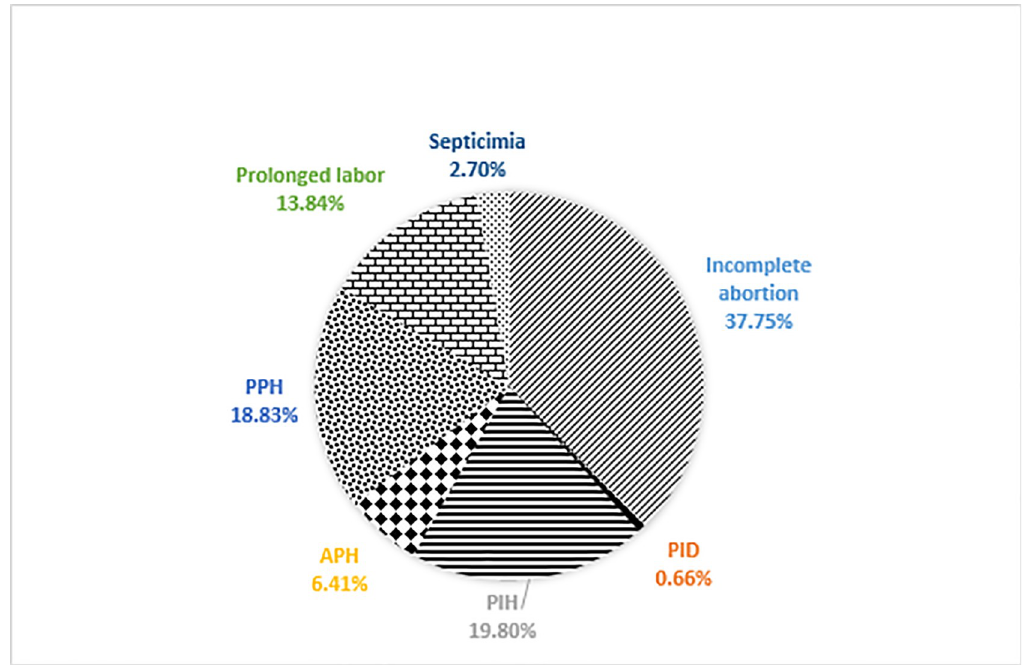
Fig 1. Percentage of total treatment cost by disease category (2015 fiscal year).